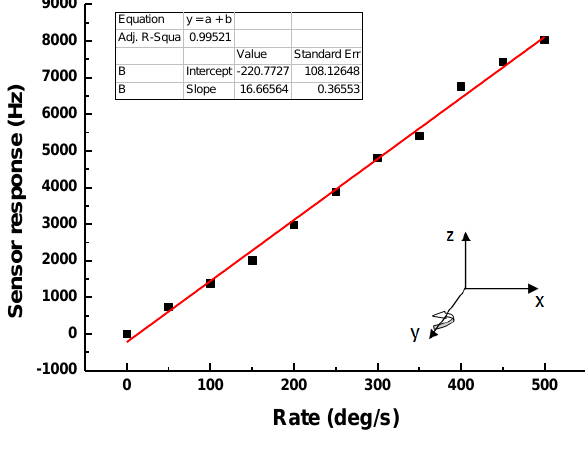
Figure 9. The sensitivity evaluation of the present SAW rate